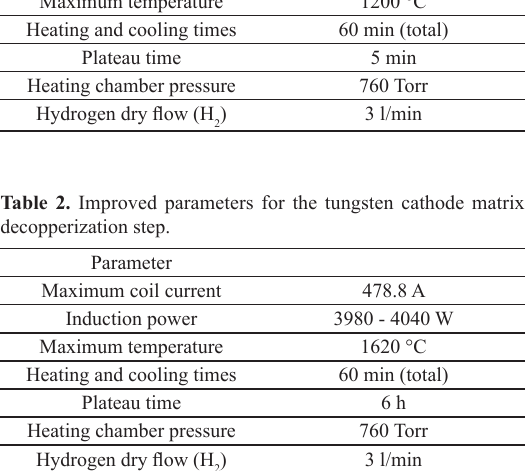
Figure 3. Flowchart for the Mo-Ru brazing paste.